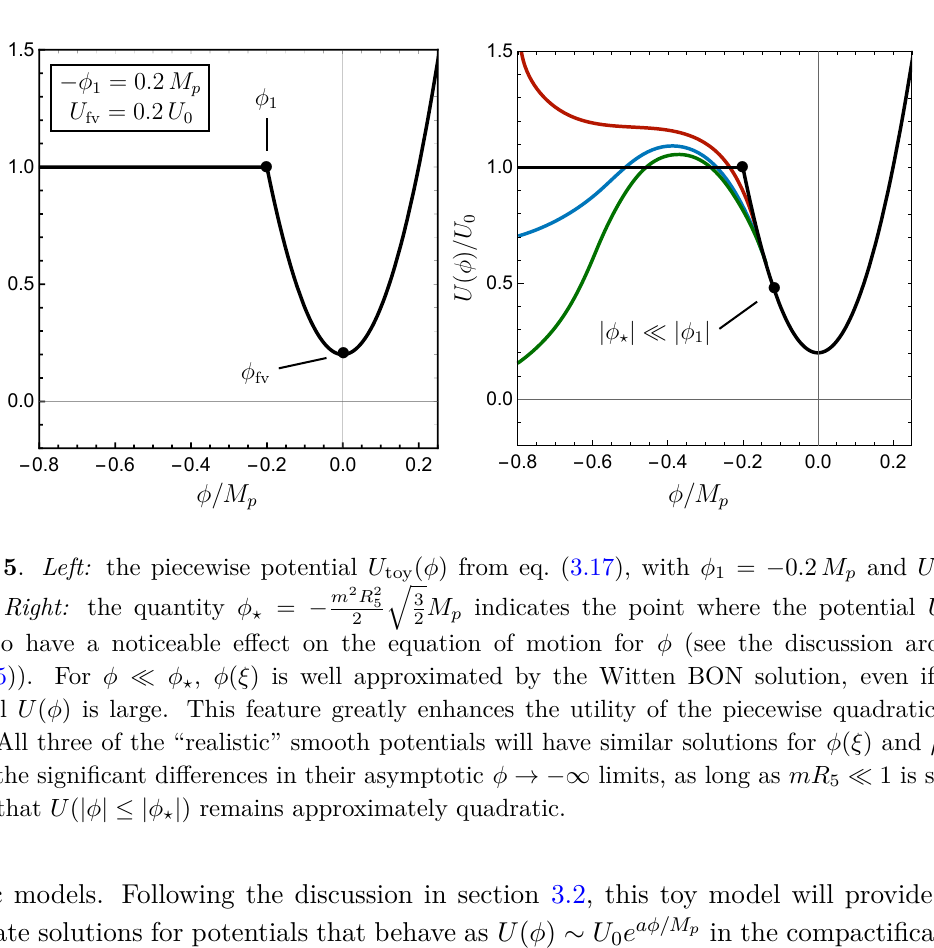
and ⇢ , with piecewise toy potential U (  ) Figure 8: Piecewise toy potential U (  ), together with more realistic examples 1 2